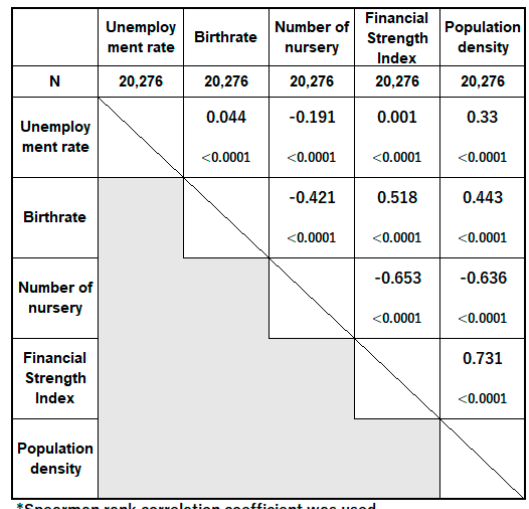
ffi cient of correlation between sociological Figure 2. Coefficient of correlation between sociological variables. 10 Figure 2. Coe